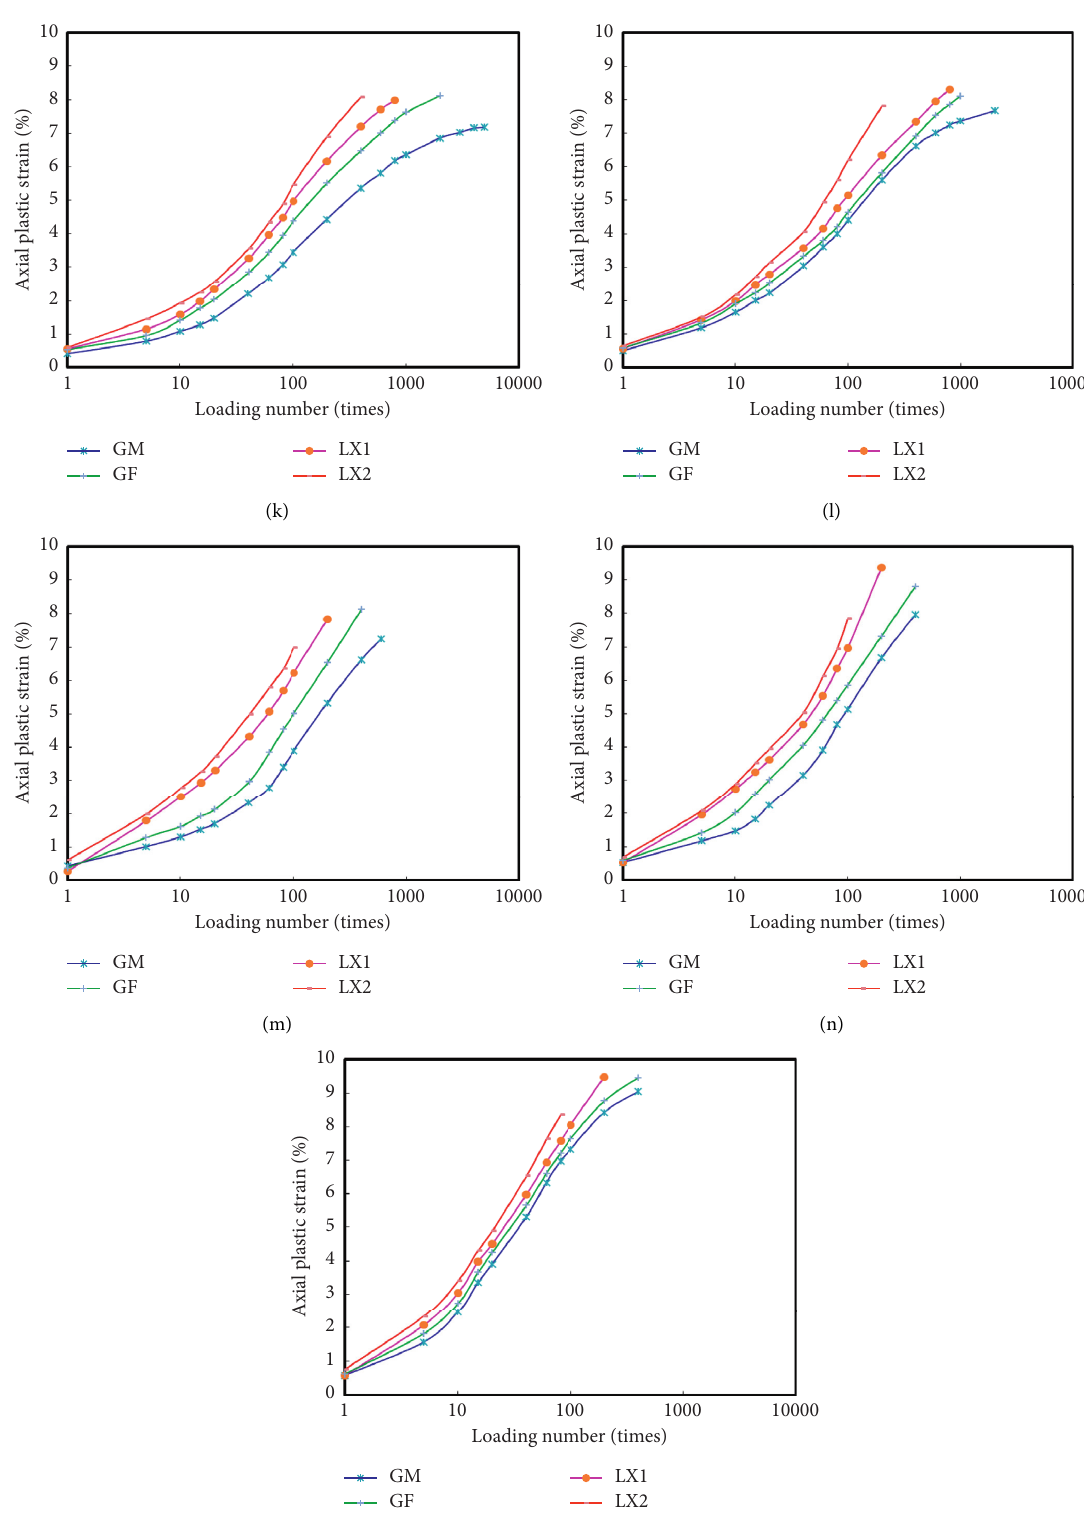
Figure 3: Relationship between the axial strain and loading number under different compaction methods. (a) (s) � 0.1, σ 0.1, σ 3 � 100kPa, (c) (s) � 0.1, σ 3 � 150kPa, (d) (s) � 0.3, σ 3 � 50 kPa, (e) (s) � 0.3, σ 3 � 100kPa, (f) (s) � 0.3, σ 3 � 150kPa, (g) (s) � 0.5, σ 3 � 50kPa, (h) (s) � 0.5, σ 3 � 100kPa, (i) (s) � 0.5, σ 3 � 150 kPa, (j) (s) � 0.7, σ 3 � 50kP, (k) (s) � 0.7, σ 3 � 100 kPa, (l) (s) � 0.7, σ 3 � 150kPa, (m) (s) � 0.9, σ 3 � 50kPa, (n) (s) � 0.9, σ 3 � 100kPa, and (o) s � 0.9, σ 3 �